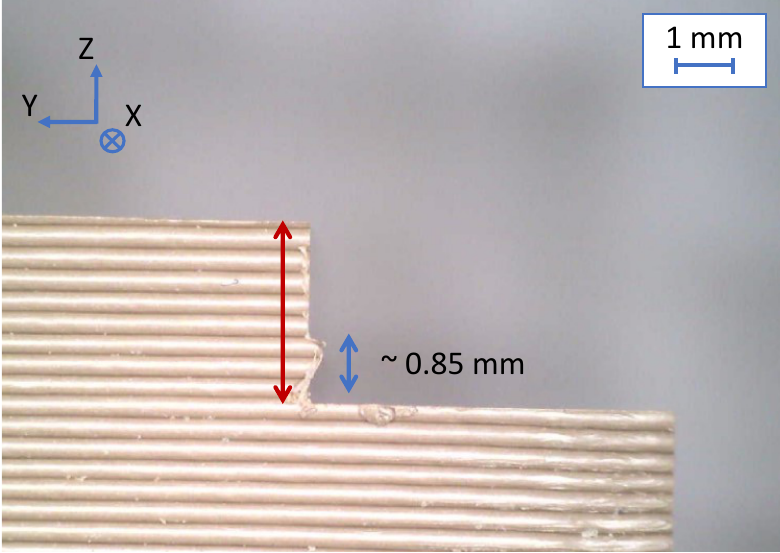
Figure 9. Side view of the milled straight shoulder for the thermoplastic